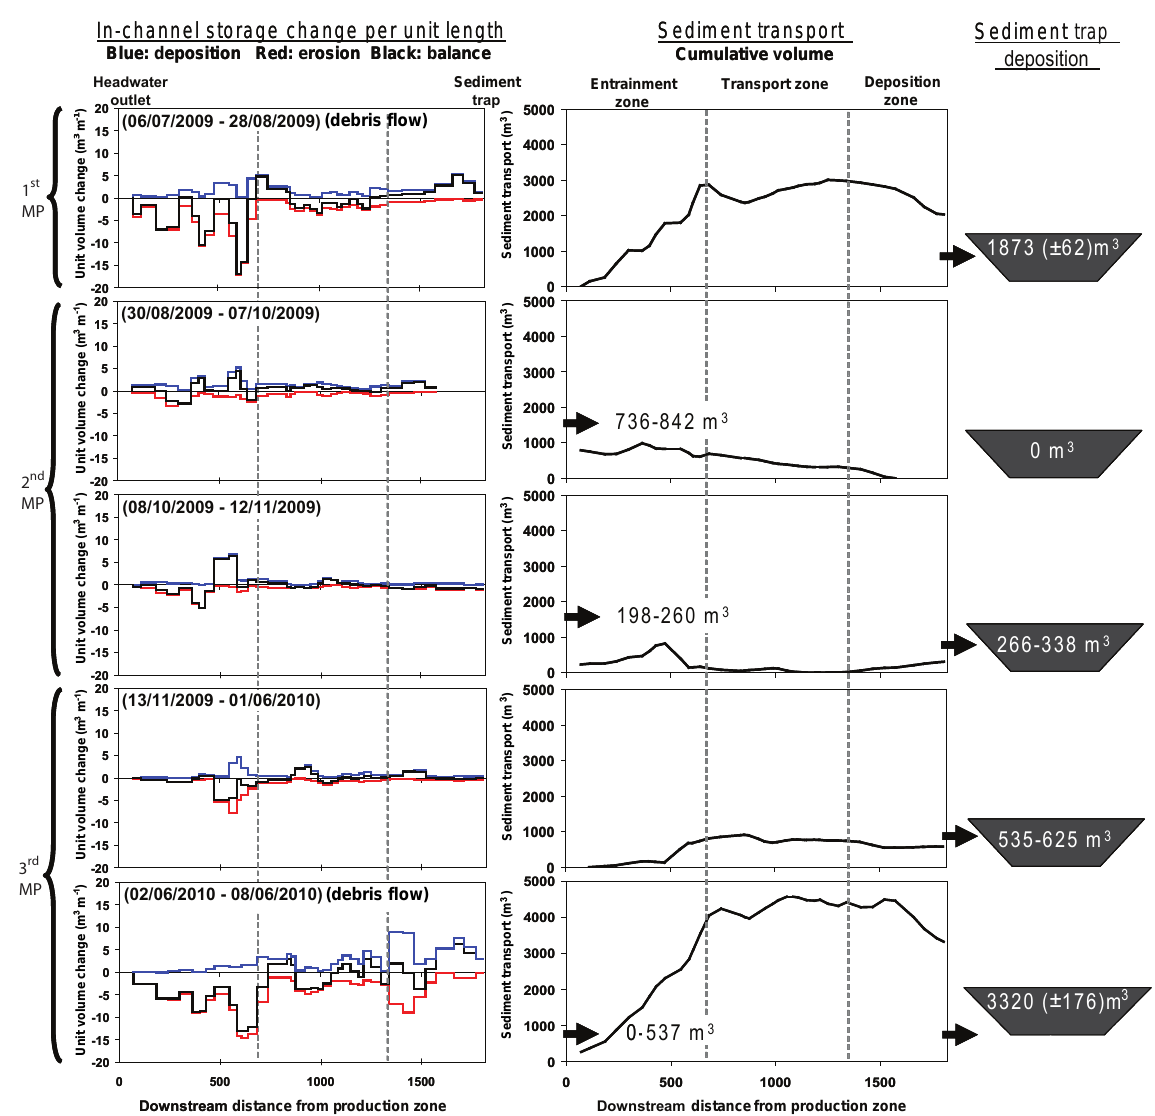
Figure 11. Torrent in-channel storage changes per unit length and sediment budgets of cumulative volumes transported in the torrent from the headwater outlet to the sediment trap downstream for each monitoring period (MP). The torrent recharge (sediment input) was estimated given the in-storage change and the volume deposited in the sediment trap (see Table 4 for details on values) (modified from Theule et al.,